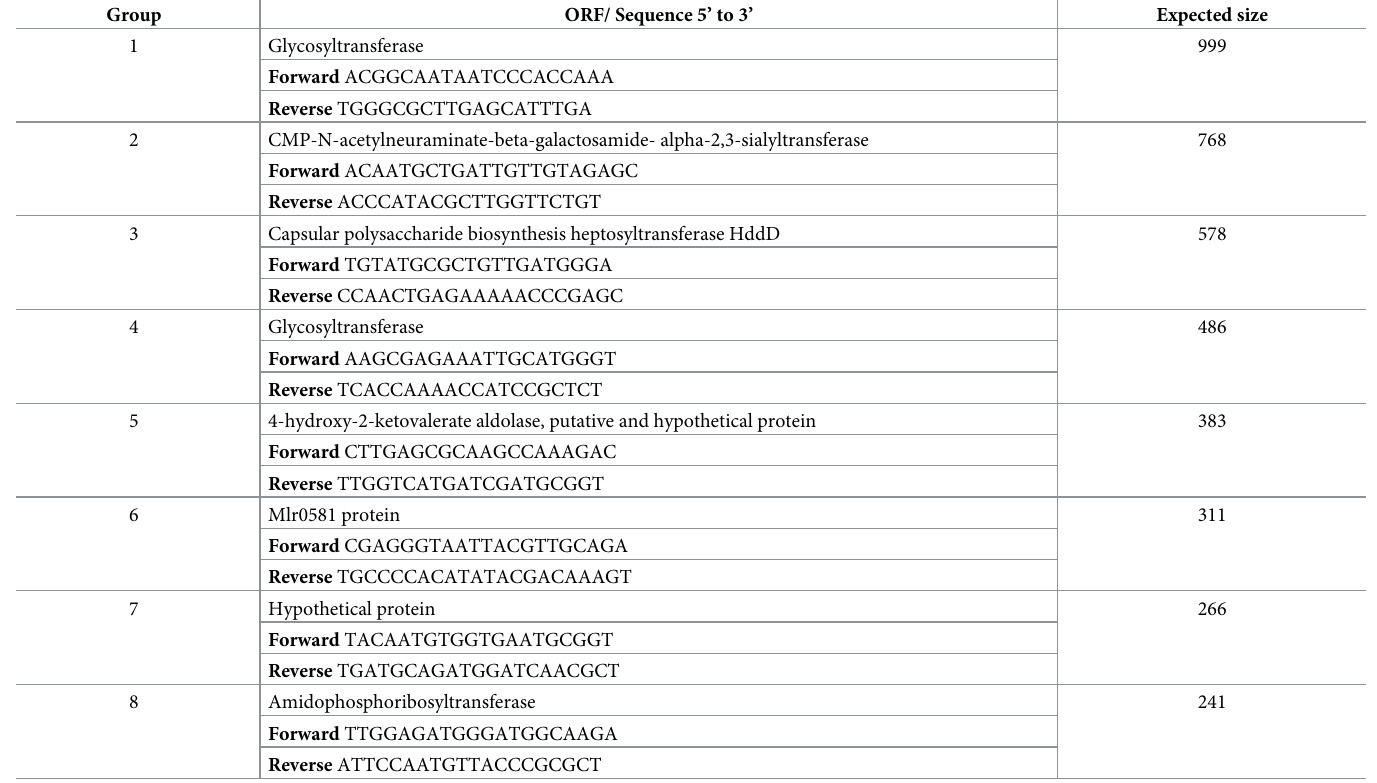
Table 1. Information of capsule multiplex-PCR